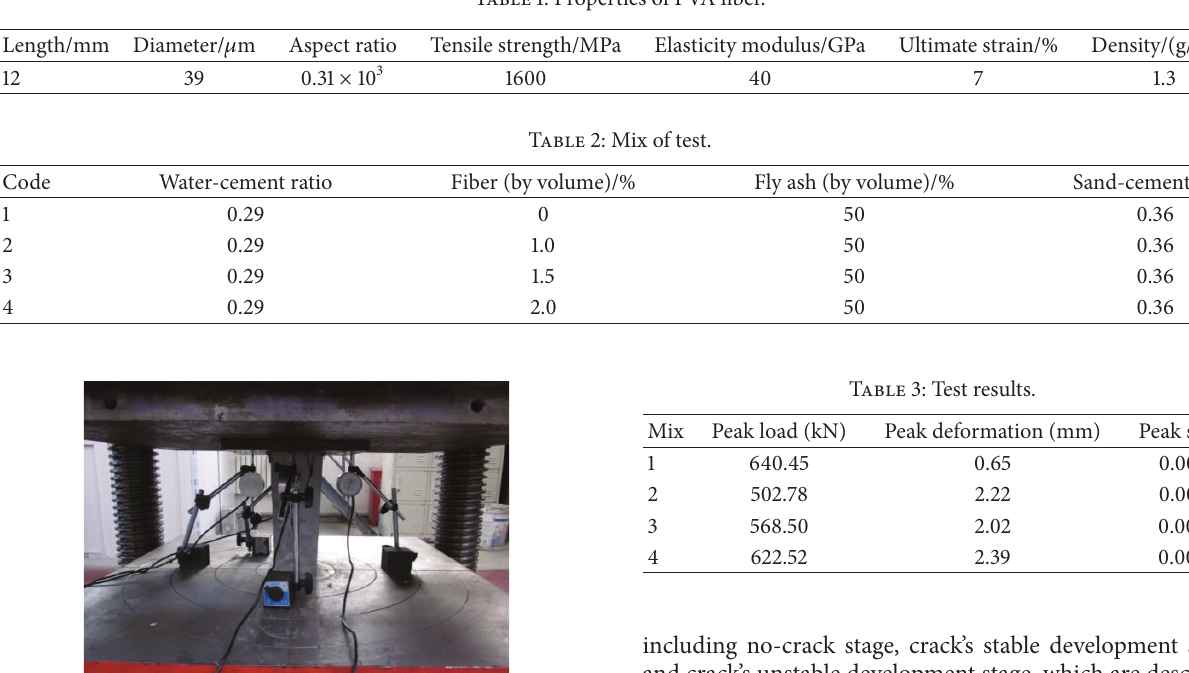
Table 1: Properties of PVA fiber.